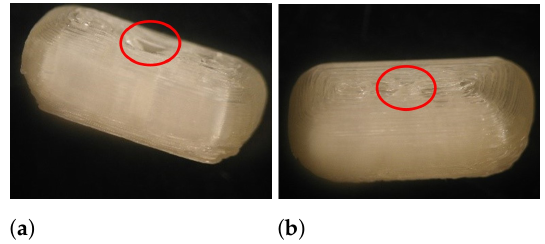
Figure 4. The load imposed on the caplet’s surface left an indentation of which the depth depends on the hardness of the product. A caplet of run 1 ( a ) and run 8 ( b ) is shown. Concerning the Brinell hardness, the significant factors were the infill (0.76 kg/mm 2 ), layer height (0.11 kg/mm 2 ) and overlap (0.10 kg/mm 2 ). Additionally, the significant